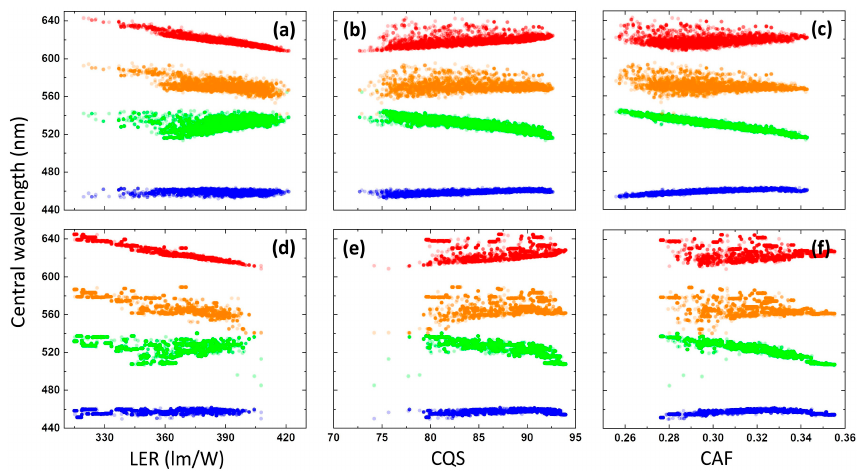
Figure 5. Correlations between the emission peak wavelengths and the objectives for optimized RY P G P B-type SSL, where (a–c) Gaussian model and (d–f) SP7 model are applied in the optimization.